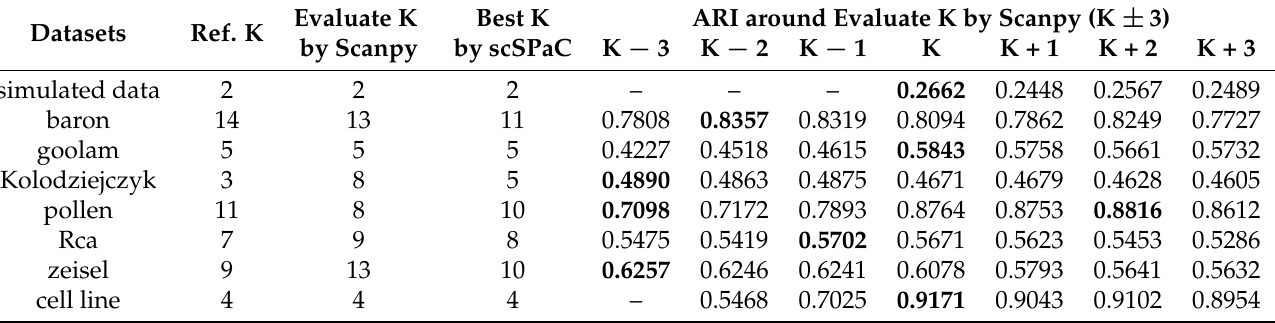
Table 6. Changes in ARI values calculated according to different cluster number K in simulated data and 7 real scRNA-seq datasets. “Ref. K” means reference K, the number of provided single cell types. “–” means the number of clusters is less than 2. The bold number indicate the best performance (ARI) of each dataset calculated according to different